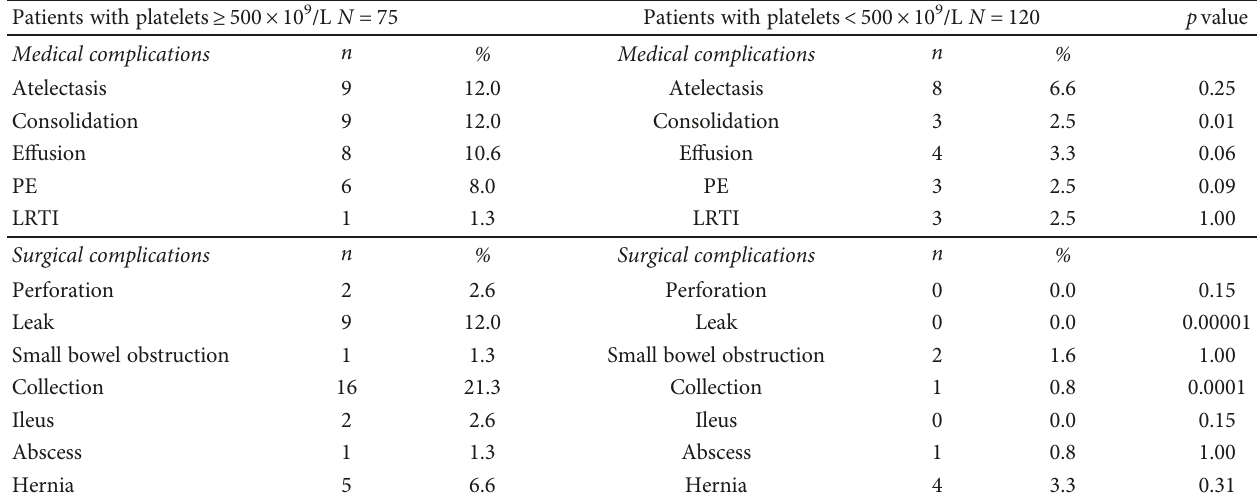
Table 1: Breakdown of